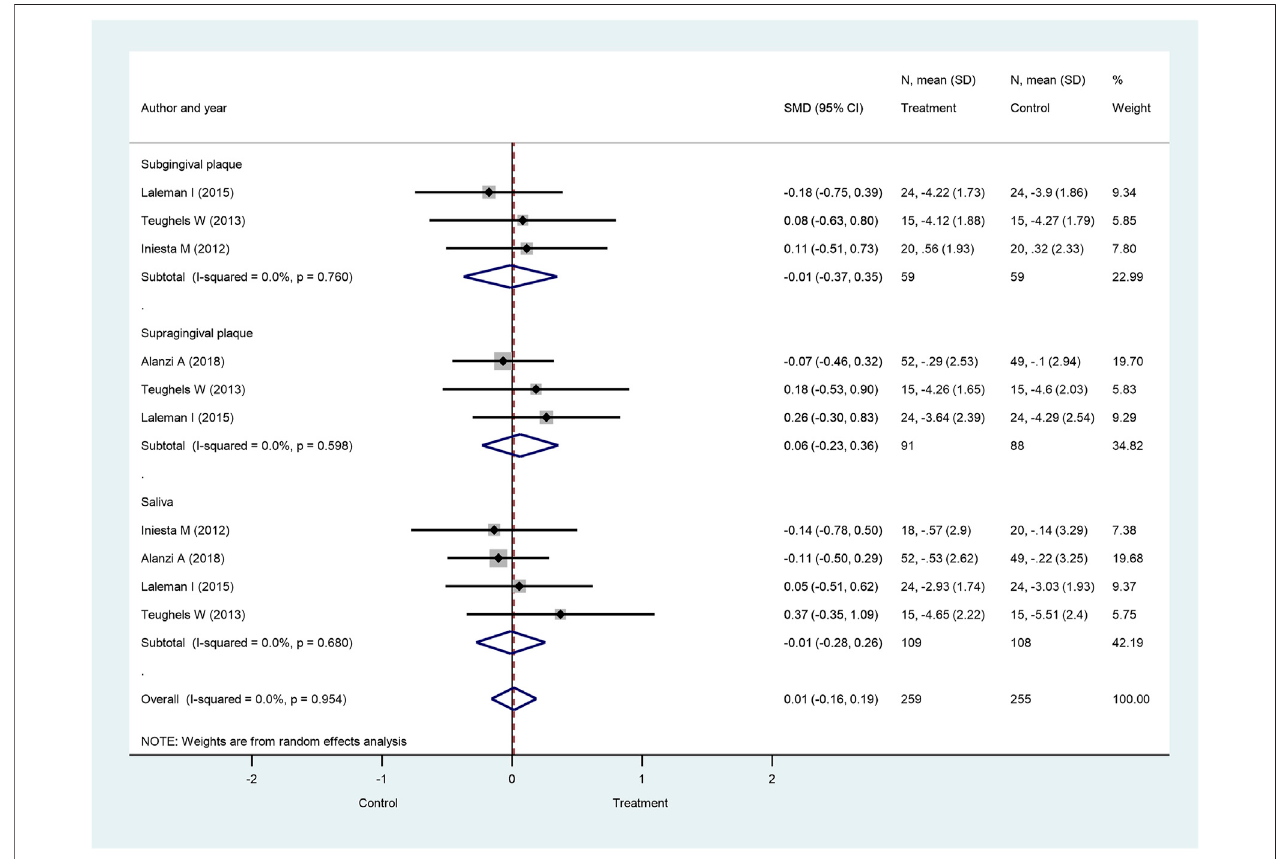
FIGURE 6 | Forest plot analysis of the change in Prevotella intermedia at 4 weeks. The overall result presented no signi fi cant difference of bacterial decrease when both treatment and control groups were compared (SMD: 0.01; 95% CI: − 0.16 – 0.19; p (cid:2) 0.874).